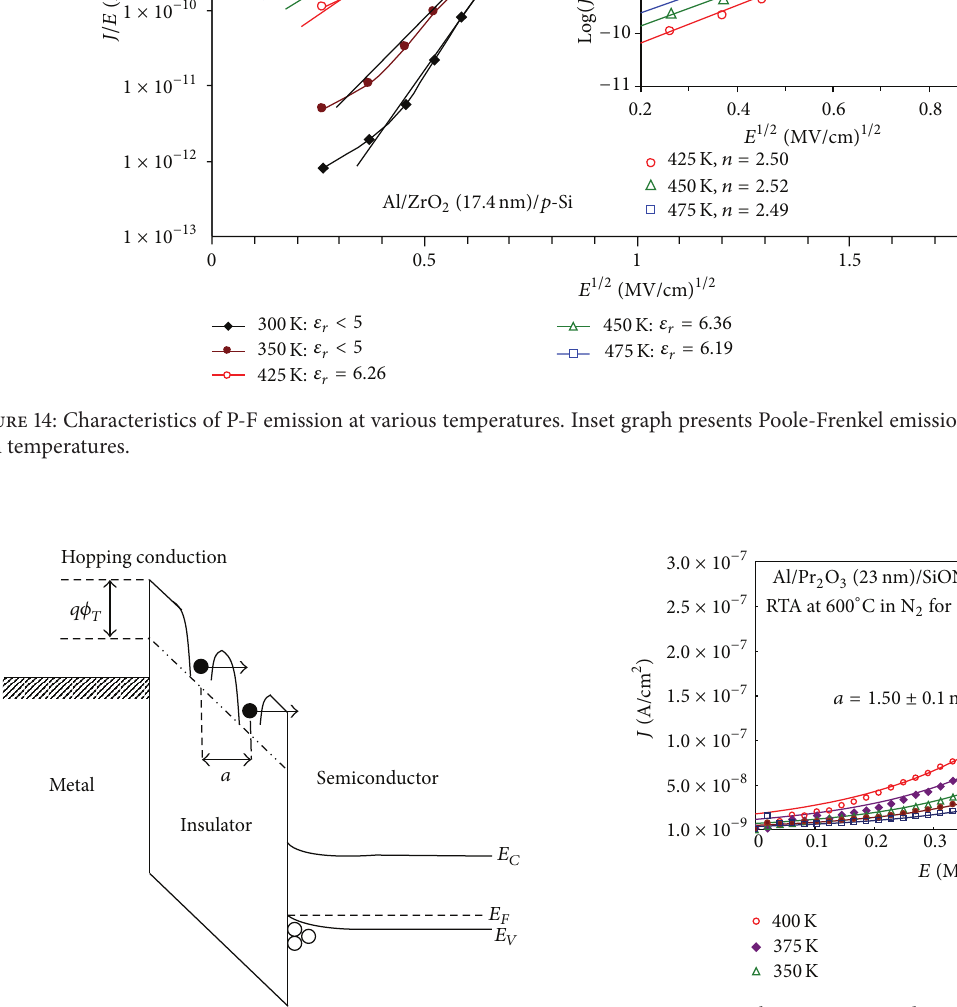
Figure 15: Energy band diagram of hopping conduction in metal- insulator-semiconductor structure.